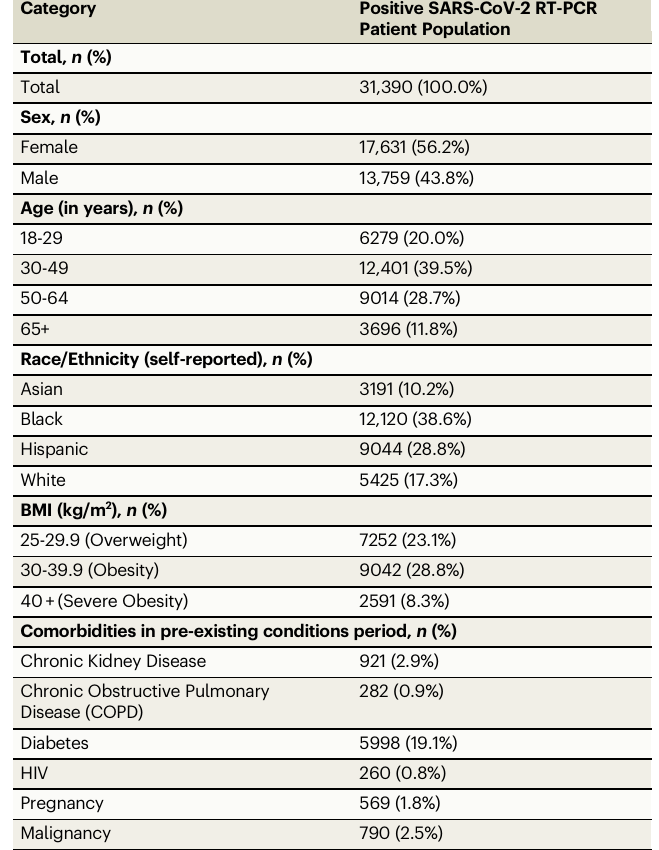
Table 2 | Clinical Classi fi cation Software (CCS) -